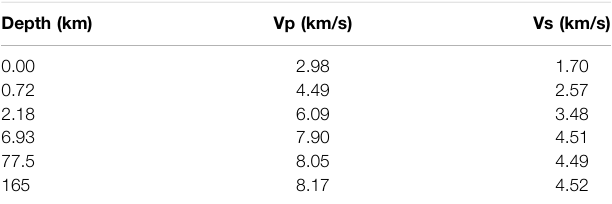
TABLE 2 | Earthquake number of ESPRH catalogs at different stages and restrictions ( Supplementary Material ).